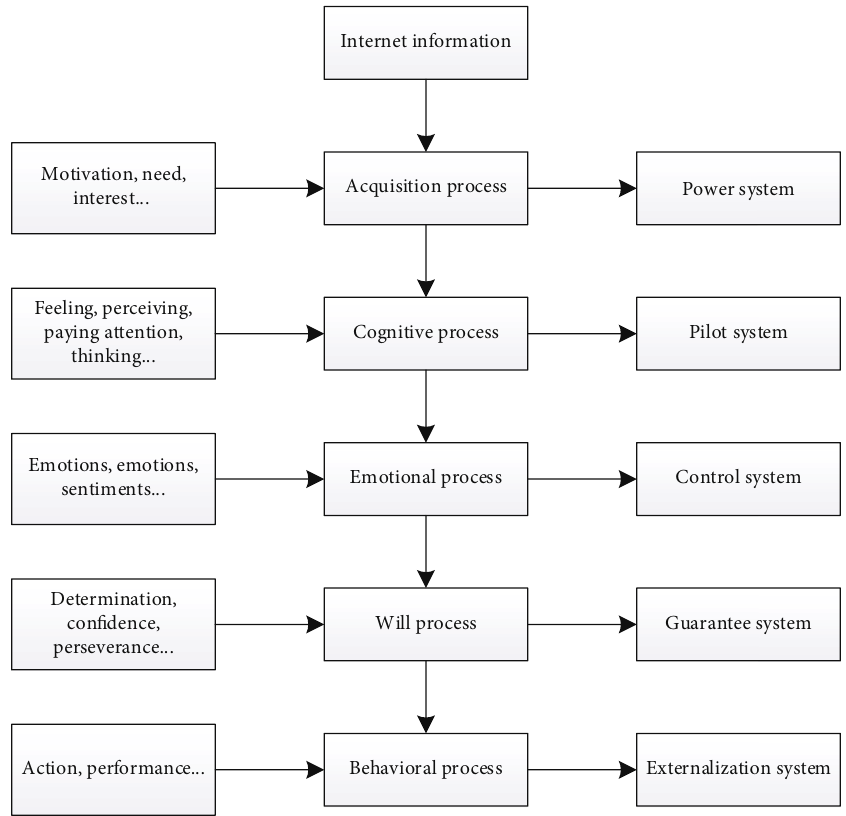
Figure 2: Educational object receiving system.